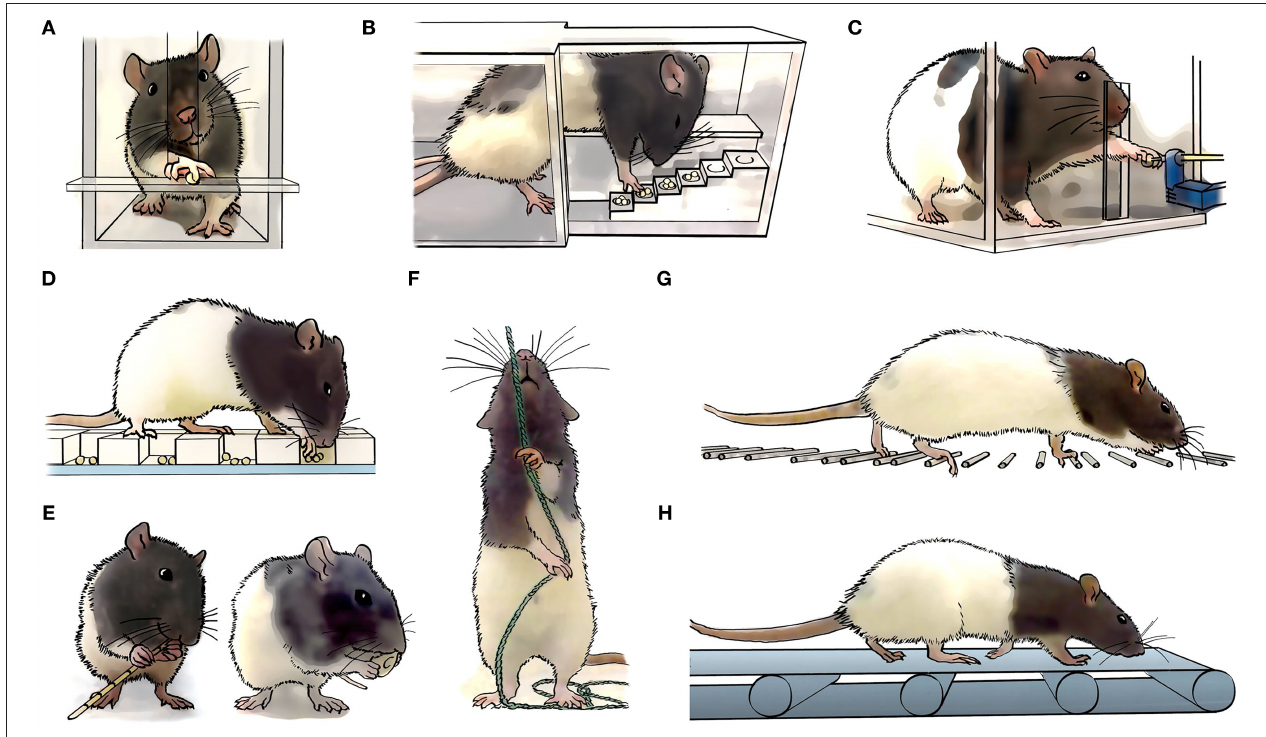
FIGURE 2 | Task specific forelimb motor assessment and rehabilitation. Long-Evans rats are commonly used to study forelimb motor control. In comparison to other rat strains, Long-Evans rats rapidly learn dexterous tasks, which can be associated with a larger cortical motor representation map ( 41). Different specific motor tasks are being used to assess the animals skills and abilities, including (A) single pellet reaching and grasping, (B) reaching and grasping in a staircase, (C) grip strength, (D) reaching and grasping form a grid, (E) food manipulation, such as pasta or cereals, (F) rope pulling, (G) horizontal ladder, and (H) treadmill